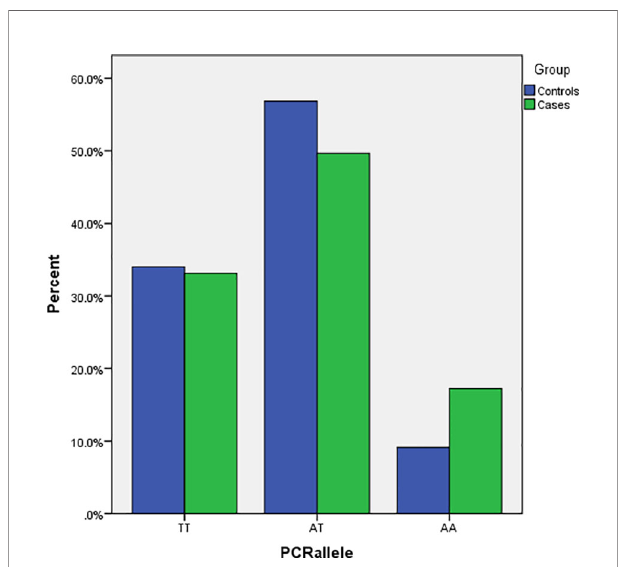
FIGURE 1 | Number of risk alleles of FTO rs9939609 gene polymorphism in the case and control groups.